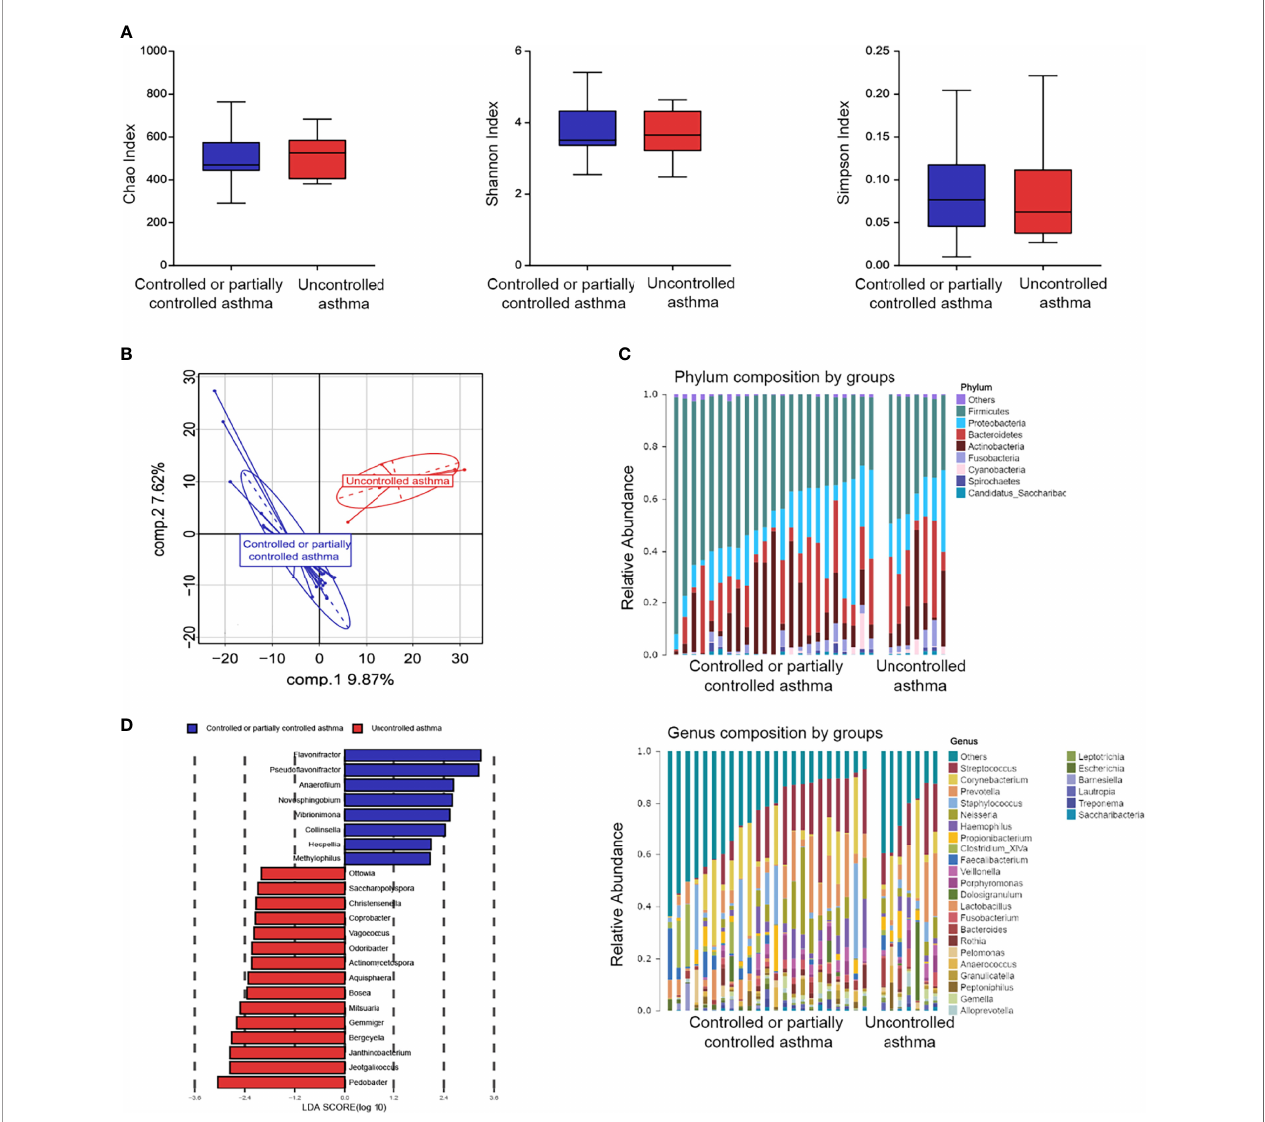
FIGURE 5 | Nasal microbiome composition in asthma according to disease control. (A) Box plots of the a -diversity in controlled or partially controlled asthma and uncontrolled asthma (Left plot, Chao index; middle plot, Shannon index; right plot, Simpson index). (B) b -diversity based on PLS-DA analysis in controlled or partially controlled asthma and Uncontrolled asthma. (C) Bar plots of the phylum and genus taxonomic levels in asthma based on asthma control. (D) Taxonomic Cladogram from LEfSe. Taxonomic distribution of nasal microbiome of each group at the different taxon (LDA Score >